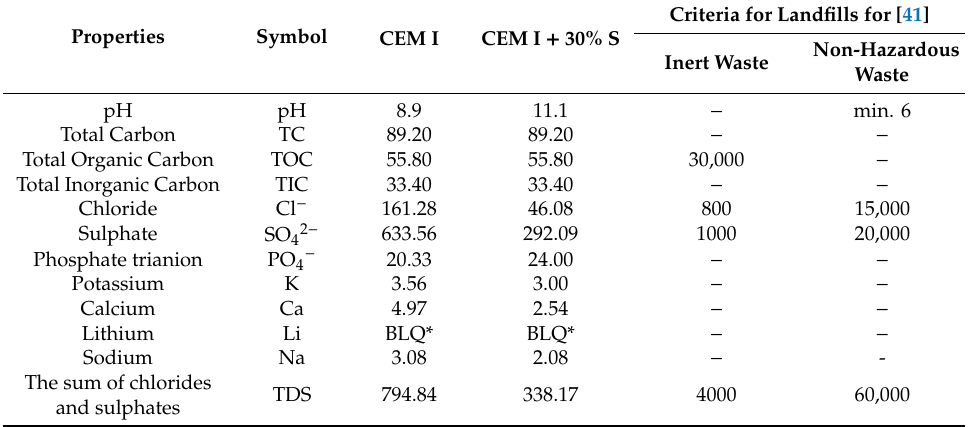
Table 11. Leachability of selected contaminants from mortar expressed in mg / kg (with pH